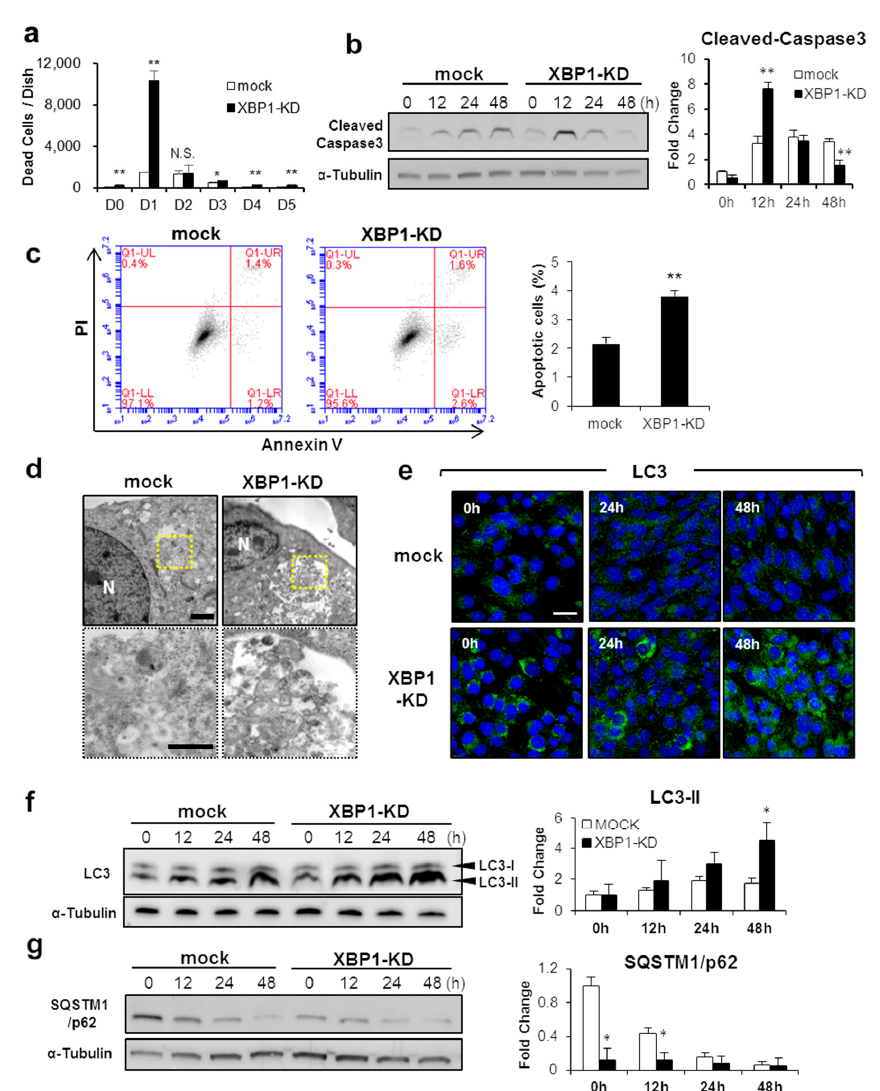
Figure4. XBP1protectsmyoblastsfromapoptosisandautophagyduringmyogenesis. ( a )Di ff Figure 4. XBP1 protects myoblasts from apoptosis and autophagy during myogenesis. ( a ) Differentiation was induced in XBP1-knockdown and mock cells. After culturing, the number of dead cells was counted at the indicated time. Results are means + SEM (three biological replicates).